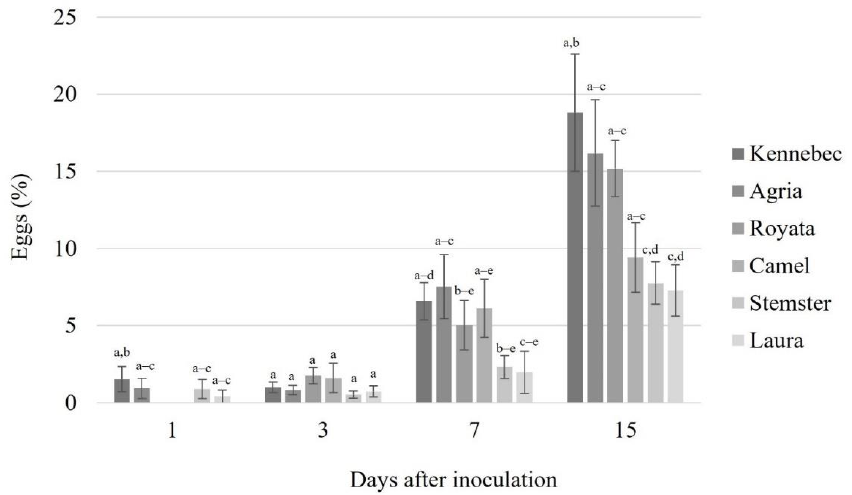
Figure 3. Percentage of Pratylenchus penetrans eggs deposited relatively to the nematodes inside potato roots of cultivars Kennebec, Agria, Royata, Camel, Stemster, and Laura at 1, 3, 7, and 15 days after inoculation with 750 P. penetrans mixed stages/plant. Data are the means of eight replicates ± SE. Means followed by different combination of letters differ significantly at p < 0.05, according to the Fisher LSD test.